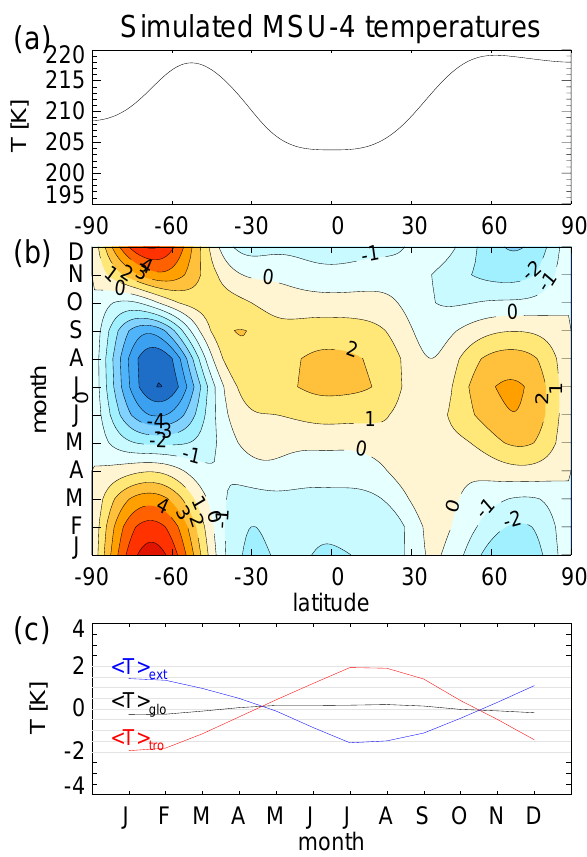
Fig. 1. Climatological mean annual cycle of simulated MSU-4 temperatures. (a) Latitudinal structure of annual mean temperature. (b) Latitudinal structure of cosine(latitude)-weighted temperature anomalies (contour increments 1K, color coding increments 0.5K). (c) Area weighted anomalies for combined extratropics < T > ext (90S-30S, 30N-90N, blue), tropics < T > tro (30S-30N, red), and global < T > glo (90S-90N, black).